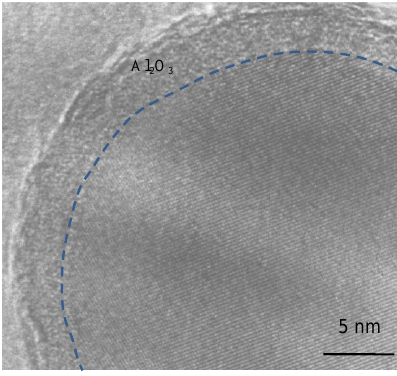
Figure 5. High resolution transmission electron microscopy (HRTEM) micrograph of the passivated TiAl 3 nanoparticle showing the surface oxide.